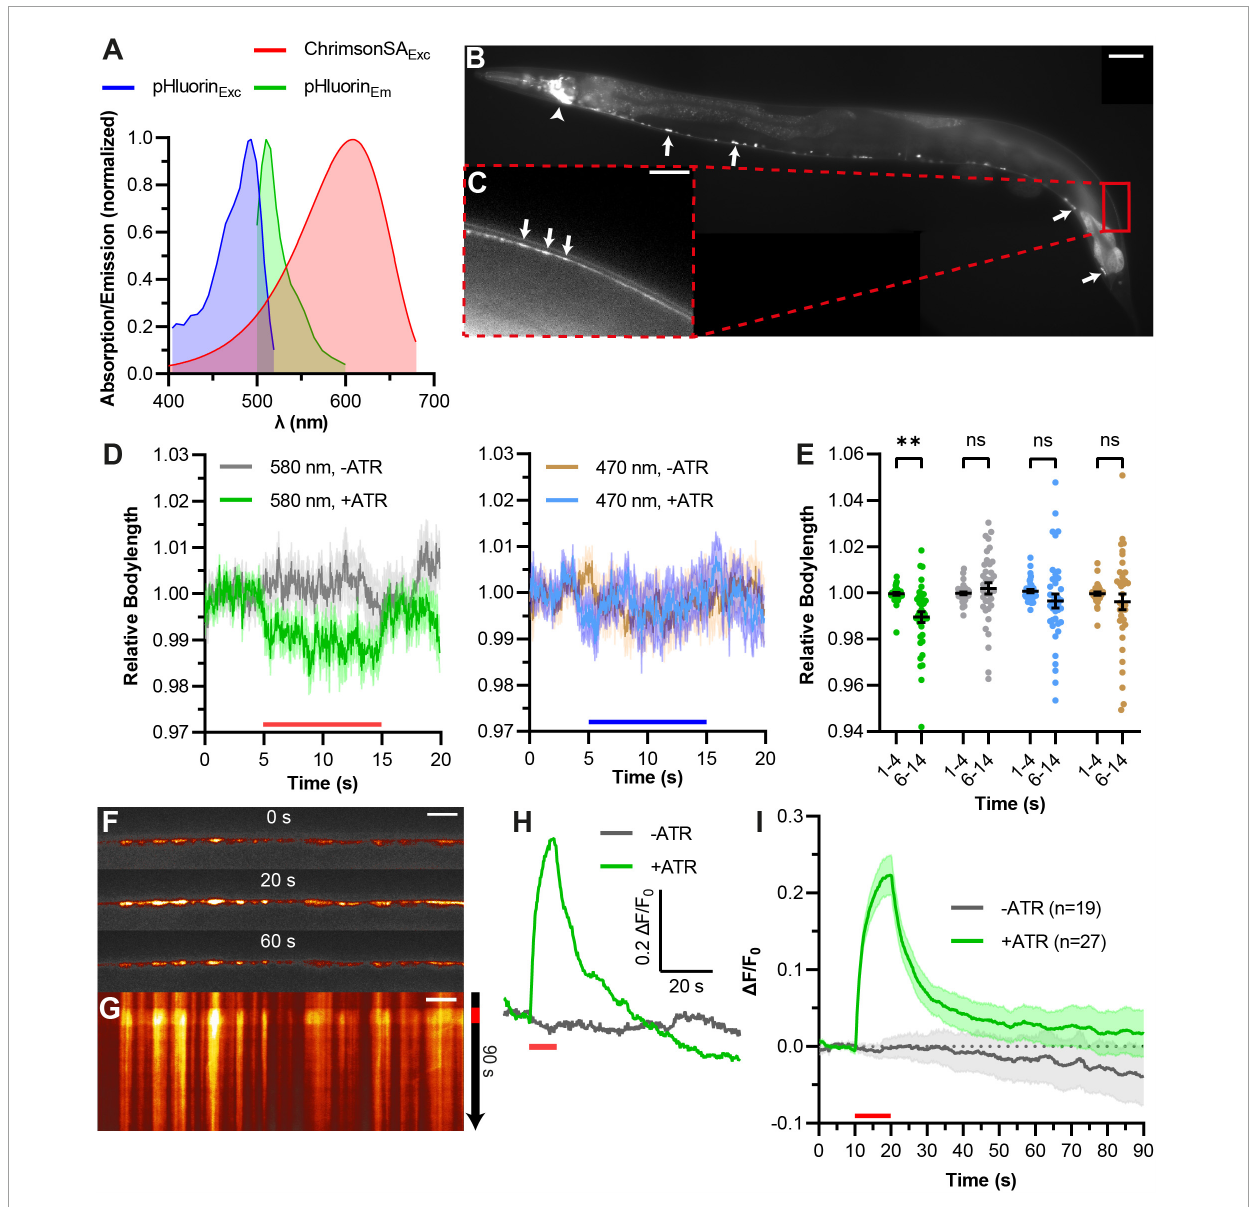
FIGURE2 Combining ChrimsonSA with pHluorin (“green pOpsicle”) for stimulation and visualization of exo- and endocytosis. (A) Relative excitation and emission spectra of ChrimsonSA and super-ecliptic pHluorin, normalized to the maximum absorption/emission amplitude. (B) Representative image of C. elegans expressing SNG-1::pHluorin in cholinergic neurons. Arrows represent cell bodies of A- and B-type motor neurons (ventral nerve cord). Arrowhead represents cholinergic neurons in the head ganglia. 40 × magnification. Scale bar, 50 µ m. (C) Enlarged view of the DNC in panel (B) . Arrows represent fluorescent puncta, representing en passant synaptic terminals. Scale bar, 10 µ m. (D) Mean relative body length ( ± SEM) of animals expressing ChrimsonSA and pHluorin optionally treated with ATR, as indicated, normalized to the average body length before stimulation. A 10 s continuous light pulse (580 or 470 nm as indicated, 40 µ W/mm 2 ; indicated by red and blue bars) was applied after 5 s. Number of animals ( n ), accumulated from N = 3 biological replicates. (E) Statistical analysis of animals shown in panel (D) . Each dot represents the mean normalized body length of a single animal during the indicated period. Two-way ANOVA with Šídák’s correction ( ns p > 0.05, ∗∗ p < 0.01). (F) Representative images of pHluorin fluorescence in the DNC of an animal treated with ATR at different time points during the pOpsicle assay, as indicated. A 10 s continuous light pulse (590 nm, 40 µ W/mm 2 ) was applied after 10 s. The ImageJ Smart Look-Up-Table was used. 100 × magnification. Scale bar, 5 µ m. (G) Kymograph representing the change in fluorescence of the DNC represented in panel (F) over a time course of 90 s. The red bar indicates the period of light stimulus. Scale bar, 5 µ m. (H) Representative traces of normalized DNC fluorescence of individual animals with or without ATR. A 10 s continuous light pulse (590 nm, 40 µ W/mm 2 ) was applied after 10 s (red bar). (I) Mean ( ± SEM) change in DNC fluorescence of animals supplemented with and without ATR. A 10 s continuous light pulse (590 nm, 40 µ W/mm 2 ) was applied after 10 s (red bar). Number of animals ( n ), accumulated from N = 4 (+ATR), and N = 3 (–ATR) biological